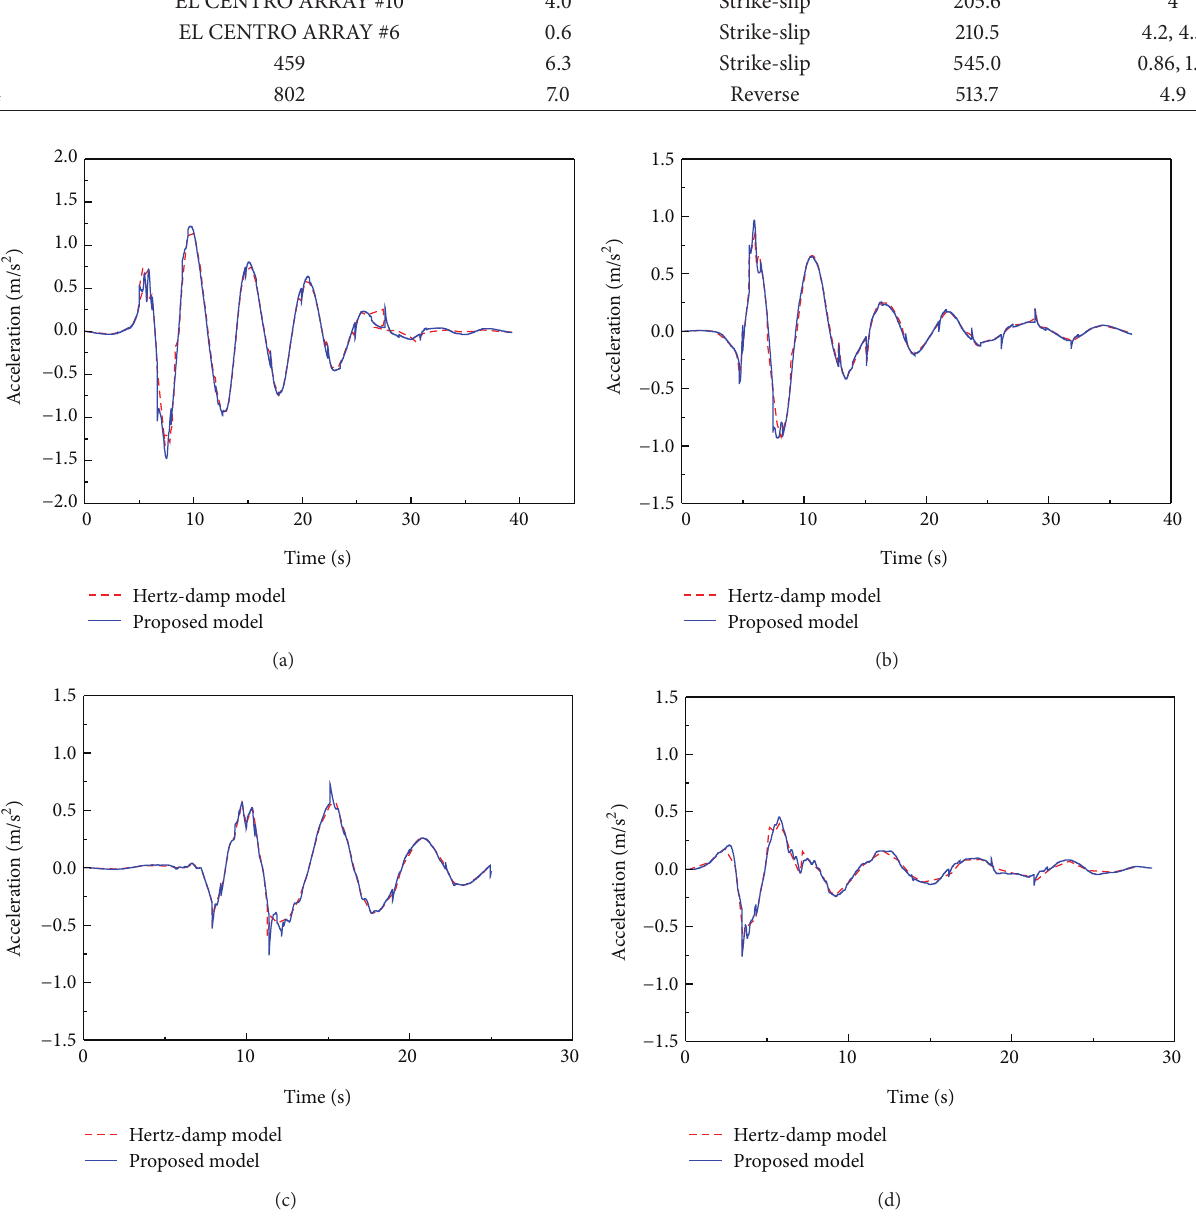
Figure 7: Acceleration time history of isolated structure (a) N1; (b) N2; (c) N3; (d)